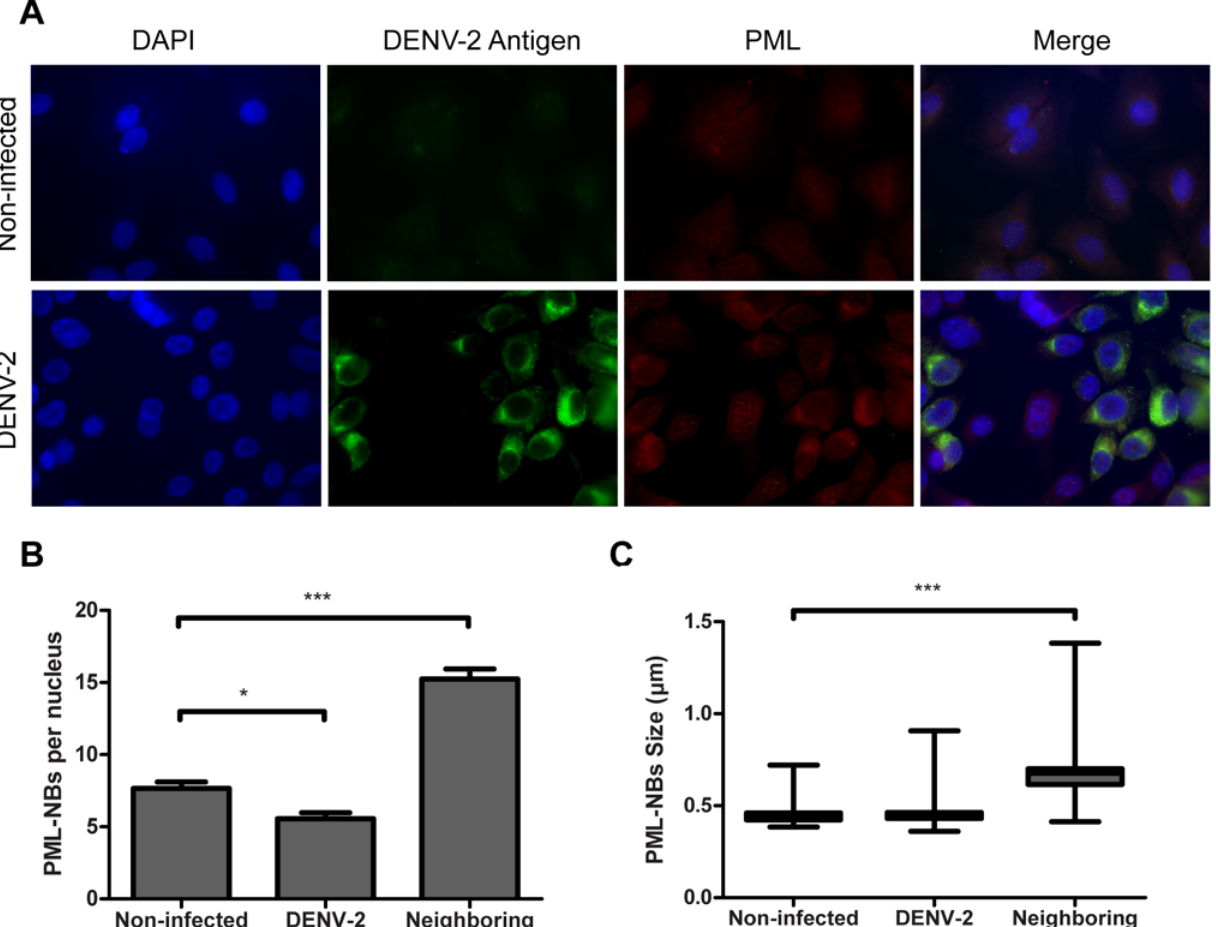
Fig 3. Effect of DENV-2 infection on PML-NBs distribution, number and size. DENV-2 infected A549 cells were fixed 24 h p.i. and a double immunofluorescence staining was performed. (A) Viral antigen expression was visualized by using monoclonal anti-E antibody and FITC-labelled anti-mouse IgG2a. PML was visualized by using anti-PML polyclonal antibodies and TRITC-labelled anti-rabbit IgG1. Cell nuclei were stained with 4',6-diamidino- 2-phenylindole (DAPI). Cells were visualized by confocal microscopy. Magnification: 600 X. (B) Quantification of the mean number of PML-NBs in the nuclei of non-infected, DENV-2 infected and DENV-2 infected neighboring A549 cells at 24 h p.i. 50 cell nuclei were counted for each condition. The reported values are mean ± SD. (C) Determination of the mean diameter of PML-NBs in non-infected, DENV-2 infected and DENV-2 infected neighboring A549 cells represented as a box and whiskers plot. The box extends from the 25th percentile to the 75th percentile. The horizontal line represents the median and the whiskers extend down to the smallest value and up to the largest. PML-NB sizes from 100 non-infected, DENV-2 infected or DENV-2 infected neighboring cells were measured. Asterisks indicate a significant difference ( *** p < 0.001; ** p < 0.01; * p < 0.05).